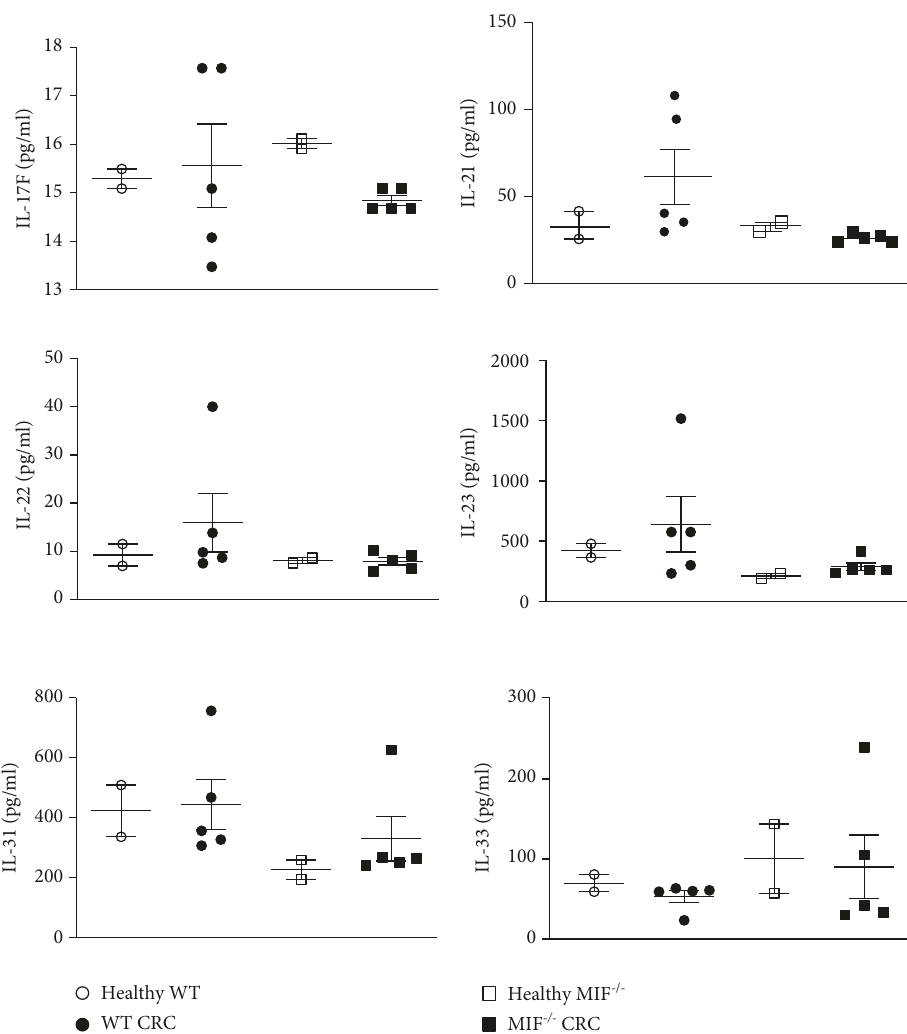
Figure 8: Expressions of Th17-related cytokines. The expressions of IL-17F, IL-21, IL-22, IL-23, IL-31, and IL-33 were detected by ELISA from colonic protein. Healthy and CRC proteins from WT and MIF -/- mice were analyzed. Data are representative of one experiment and are plotted as the means ( ± SEM), n = 2 mice per control group, and n = 5 mice per treated